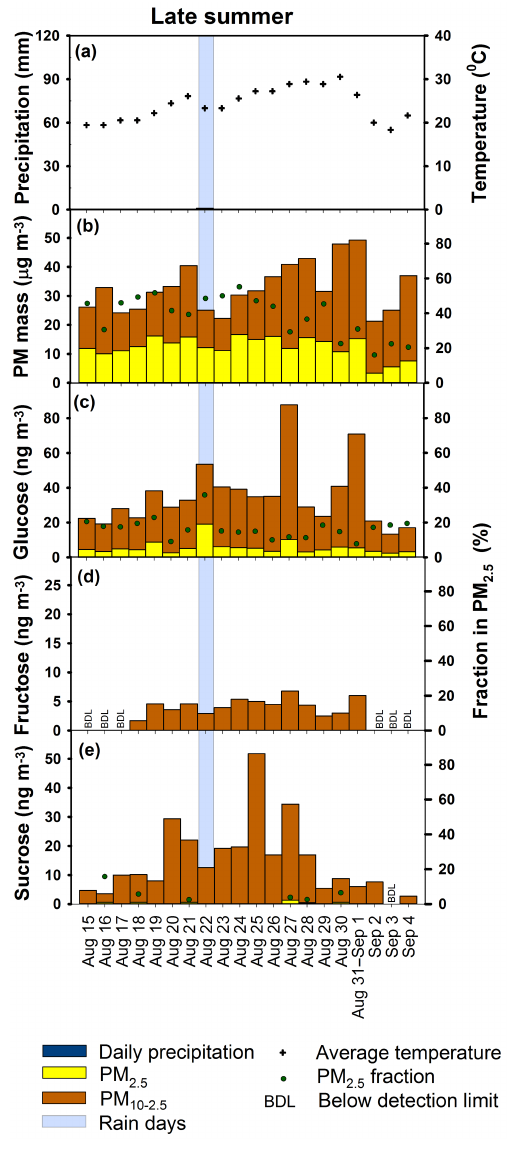
Figure 2. Temporal variation in precipitation and average temper- ature (a) in Iowa City, IA, in the late summer of 2013. Ambient concentrations of PM mass (b) , glucose (c) , fructose (d) , and su- crose (e) in coarse and fine size fractions. The percent of PM and bioaerosol tracer mass in fine particles is shown on the right axis for samples in which the analyte was detected in both size